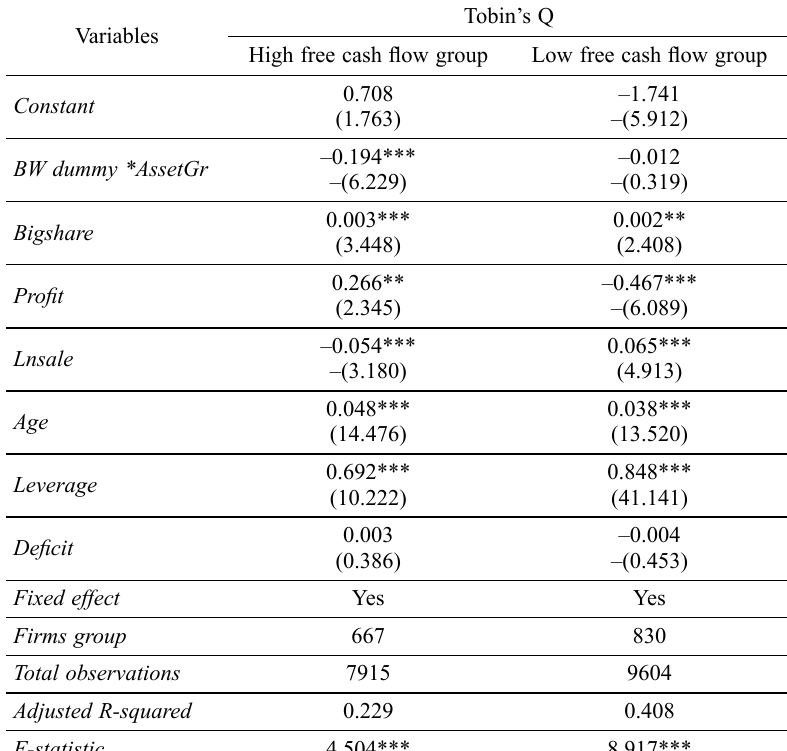
Table 5. Effect of growth on firm value for detachable BW-issuing firms